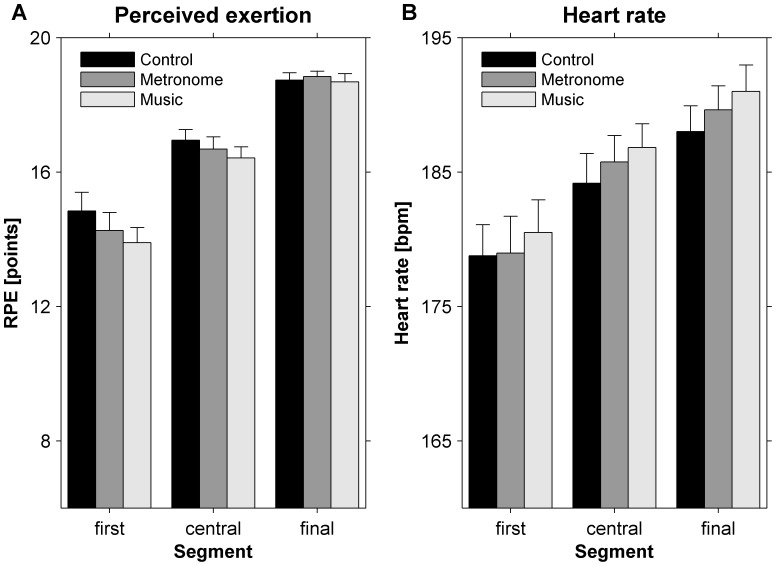
Perceived exertion (A) and heart rate (B) data for the first, central, and final 1-minute segments of the exhaustion phase for control (black), metronome (dark gray), and motivational music (light gray) conditions.Error bars represent the standard error. RPE and heart rate of each segment differed significantly from each other.